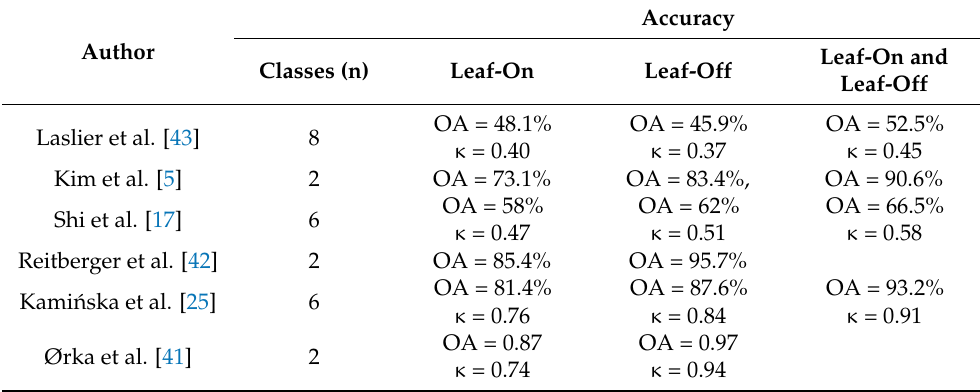
Table 7. Species classification accuracies for studies comparing or integrating ALS data from both